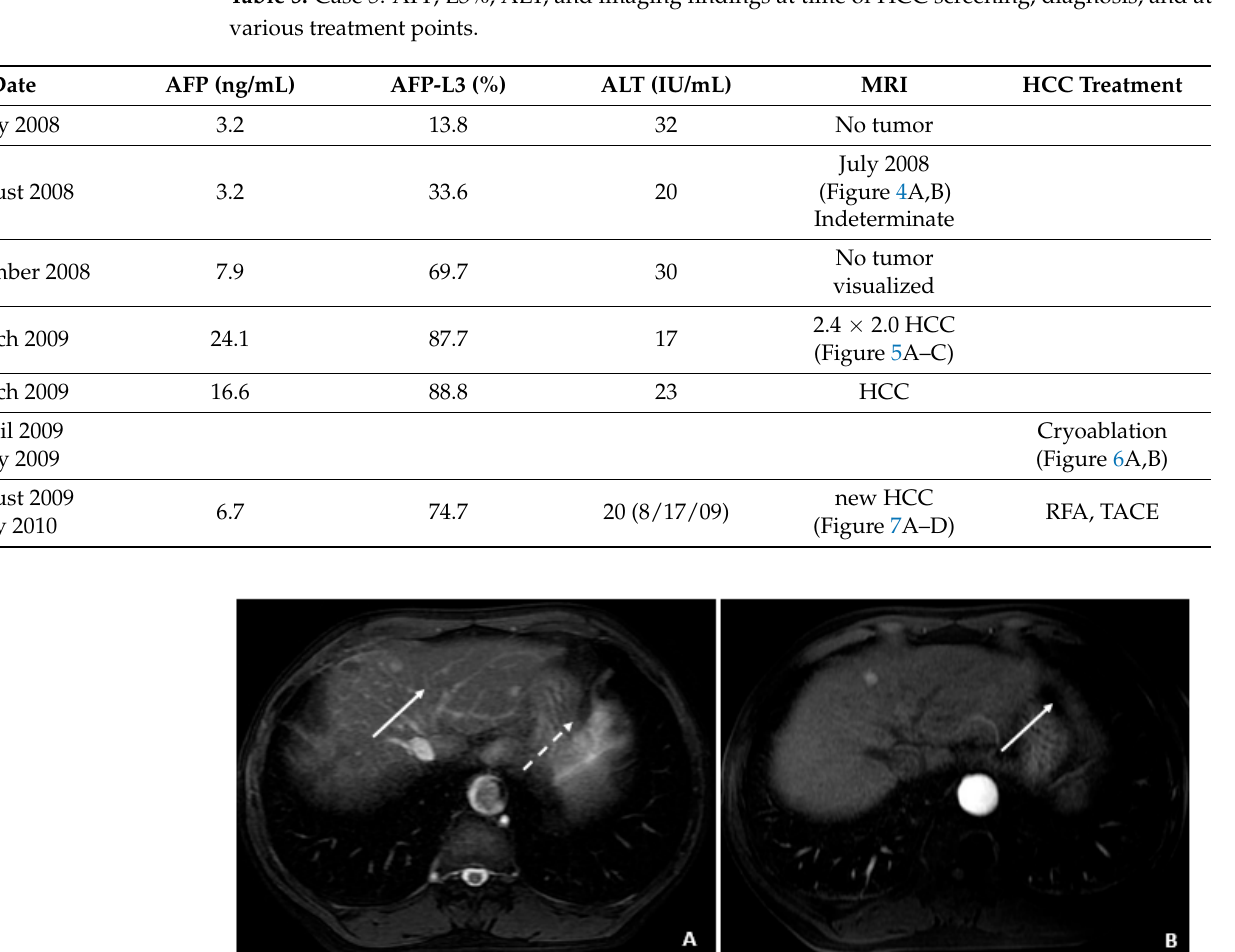
Figure 5. Triphasic CT at the time of HCC diagnosis (March 2009). ( A ) The precontrast image shows a hypodense lesion (arrow) at the site of the punctate hyperenhancing lesion shown in Figure 4. ( B ) The corresponding arterial-phase postcontrast image reveals hyperenhancement (arrow). ( C ) The portal-phase postcontrast image shows washout (arrow), and all features are typical of HCC and confirm the diagnosis in the setting of chronic HBV. Figure 6. Cryoablation of the segment 4A HCC (April and May 2009). ( A ) The CT image through the region of the segment 4A HCC shows the cryoprobes and formation of the surrounding ice ball that accumulates as freezing cycles are applied to ablate the lesion. ( B ) A delayed postcontrast T1- weighted fat-suppressed image 1 month later shows little to no apparent enhancement in the ablated lesion (arrow).